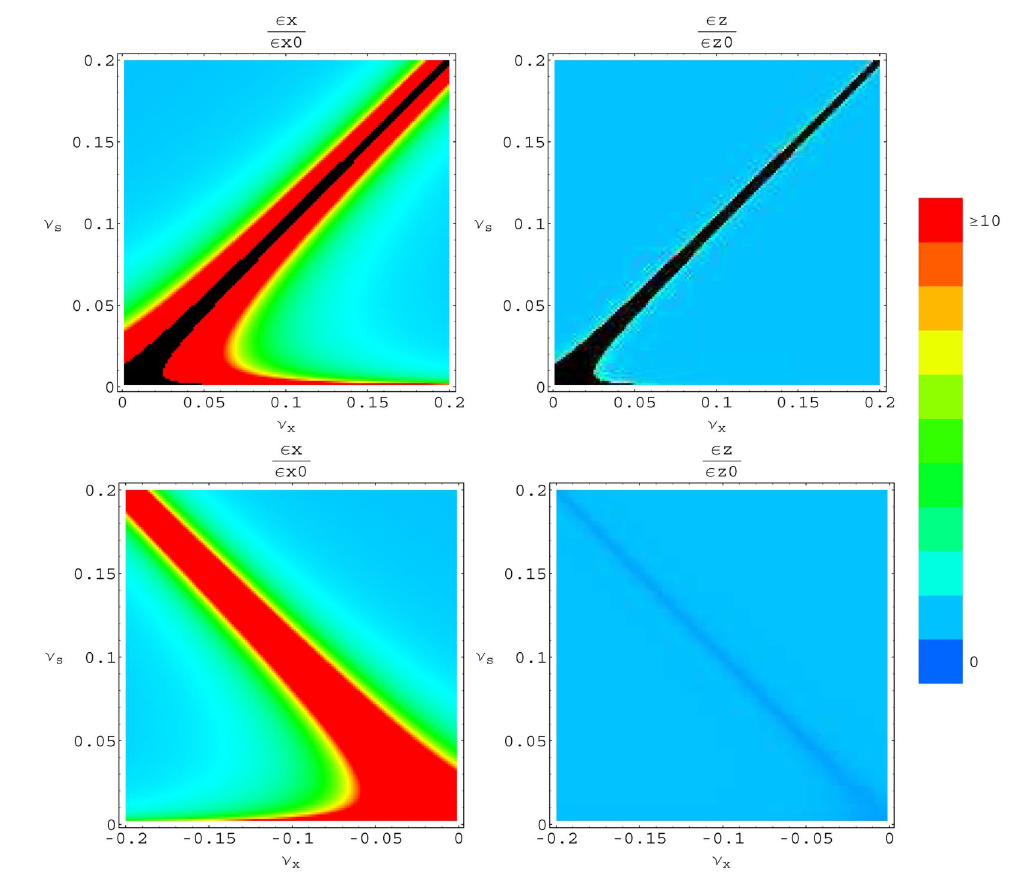
FIG. 4. (Color) Projected emittances near the sum and difference resonances due to a crab cavity. The four plots have the same meanings as in Fig. 3. The parameters are the same as those in Figs.